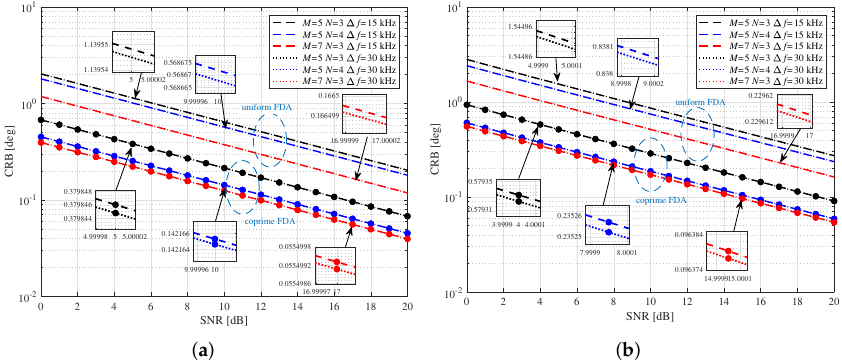
Figure 2. CRB of DOA in joint DOA-range estimation. ( a ) Deterministic signal case. ( b ) Stochastic signal case.